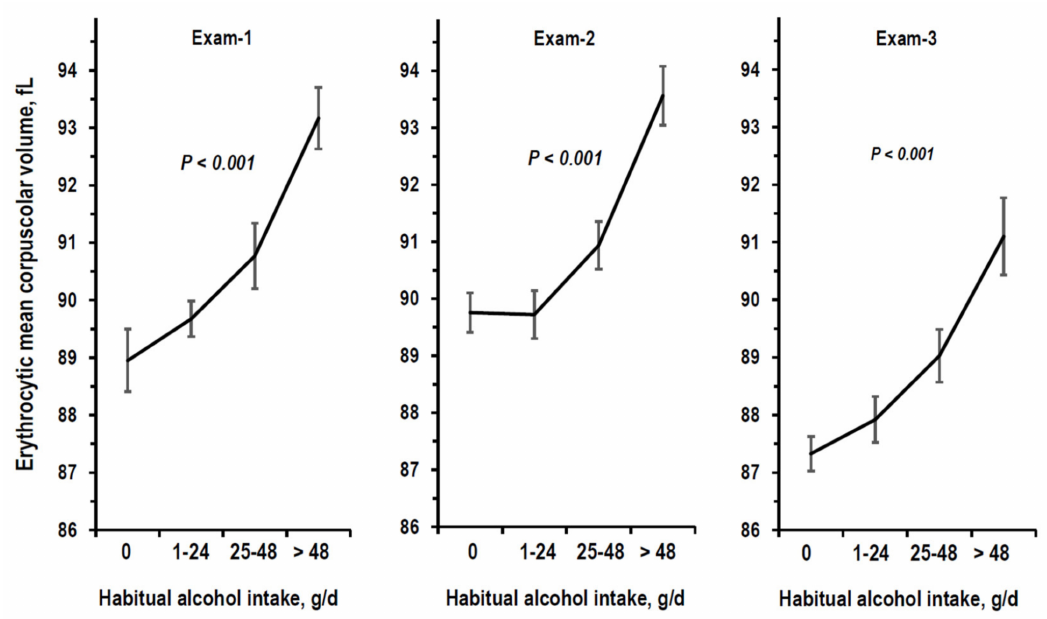
Figure 3. Mean and 95%CI of erythrocytic mean corpuscular volume by stratum of alcohol intake (g/d = g/day) at Exam-1, Exam-2, and Exam-3. Number of examinees per stratum is reported in Table 1. p -values are from non-adjusted ANOVA.